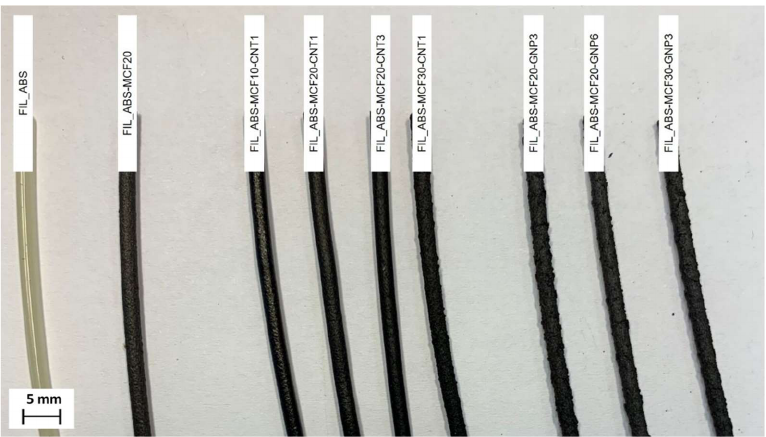
Figure 1. Extruded filaments of neat ABS, ABS/MCF, ABS/MCF/CNT, and ABS/MCF/GNP composites. Each composition is detailed in the inset.